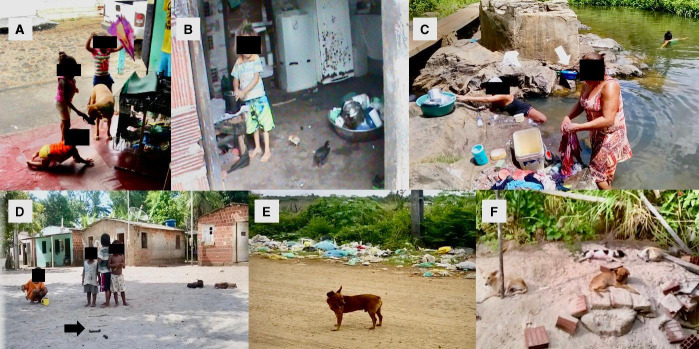
A) Interaction among children under 5 years of age with semi-restricted dog in a commercial establishment of the District of Banco Central. B) Child infected with six different species of parasites. Note the dirt floor, the storage of household utensils on the floor and the presence of domestic animals in the kitchen. District of Rio do Braço. C) Domestic activities in the Japu River. Note the presence of a basin with chicken being prepared for consumption. District of Japu. D) Children playing in a peridomiciliary environment contaminated by canine feces. District of Aritaguá. E) Semi-restricted dog in contaminated environment of the District of Couto. F) Agglomeration of unhealthy dogs in peridomicile of the Municipal Seat (Ilhéus). March to November/2016. Source: Personal File.